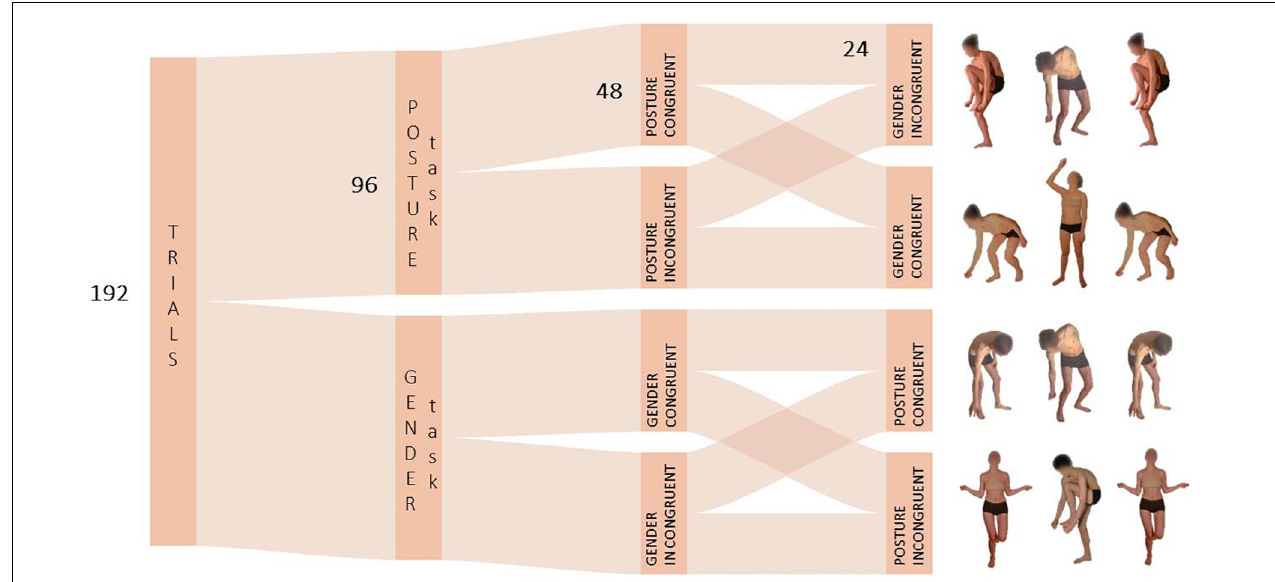
FIGURE 4 | Schematic depiction of the task structure in Experiment 3. In the Posture Task, the feature to be attended was the opening/up-ward vs. closing/down-ward movement of bodies with no emotional valence.